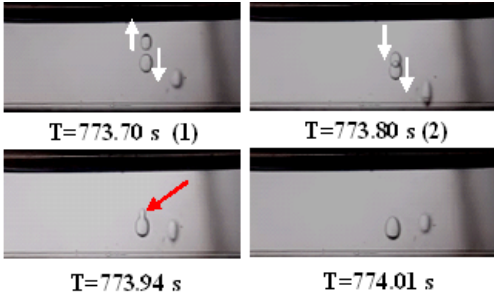
Figure 11. Pinch-o ff and forming thread (Ca E = 0 . 321). Fig. 11. Pinch-off and forming thread (Ca